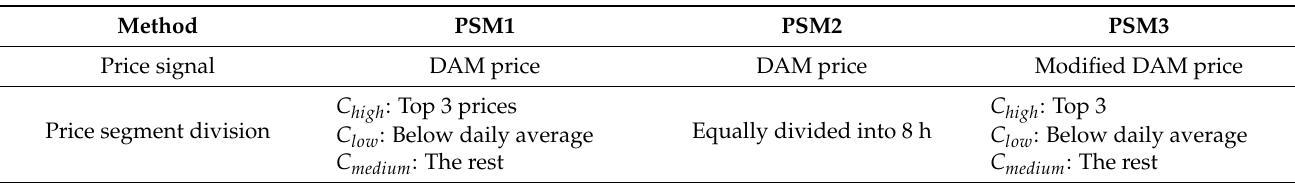
Figure 2. Normalised baseloads of six grids compare with two price signals. Table 1. PSM methods